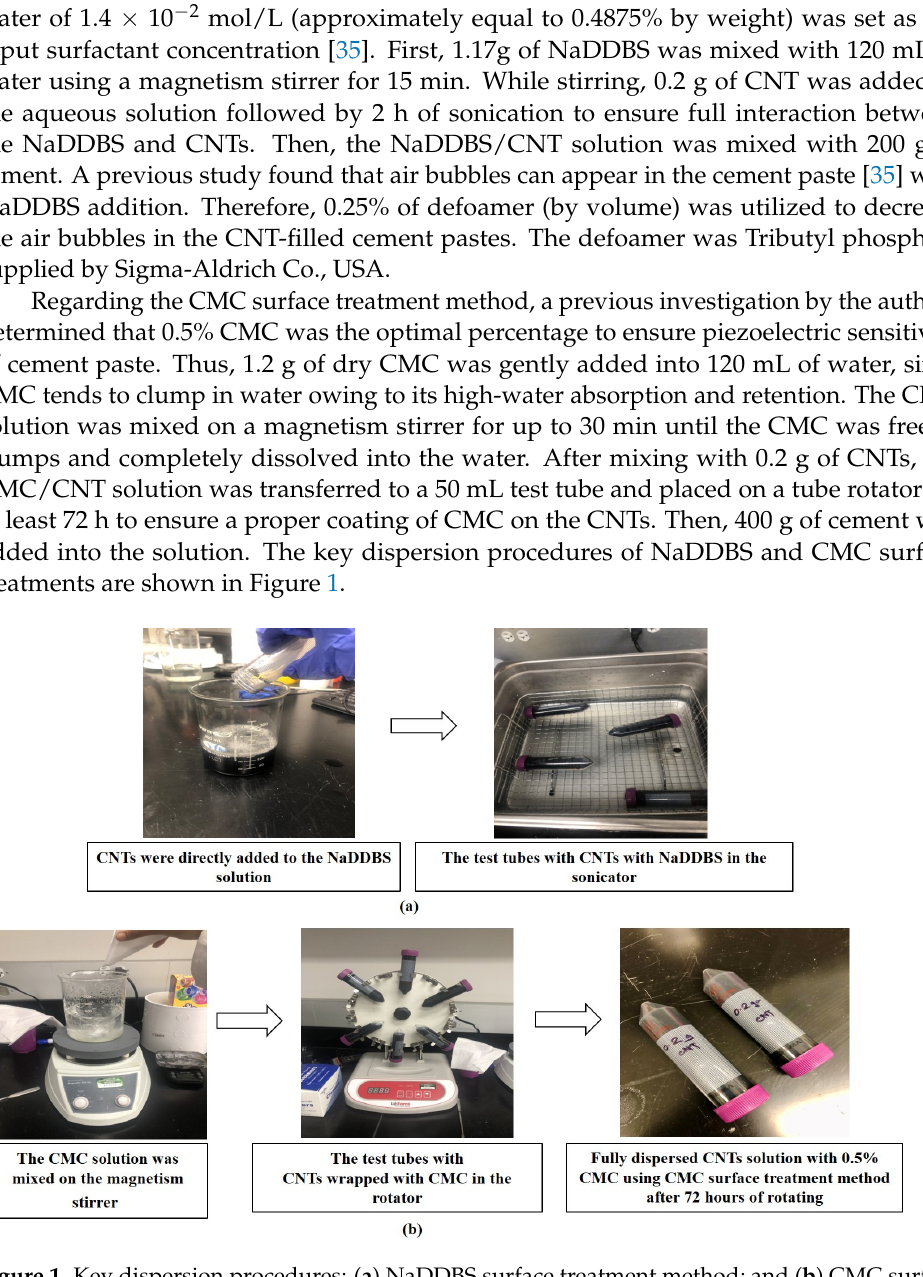
Figure 1. Key dispersion procedures: ( a ) NaDDBS surface treatment method; and ( b ) CMC surface treatment method.